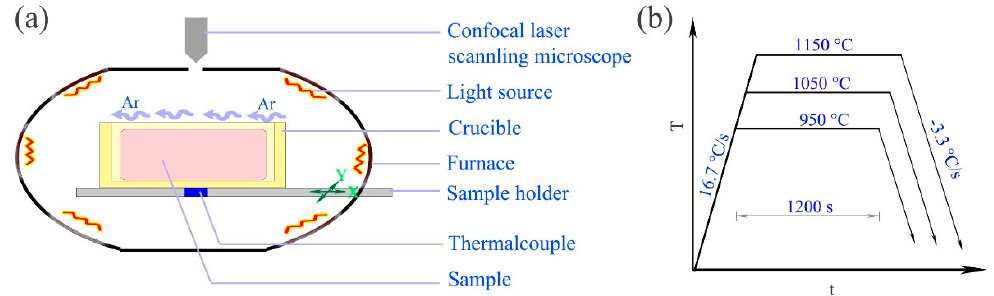
Figure 3. Illustration of the experimental setup and temperature curves of the in situ observation experiments: ( a ) illustration of the experimental setup; ( b ) temperature curves of the in situ observation experiments.